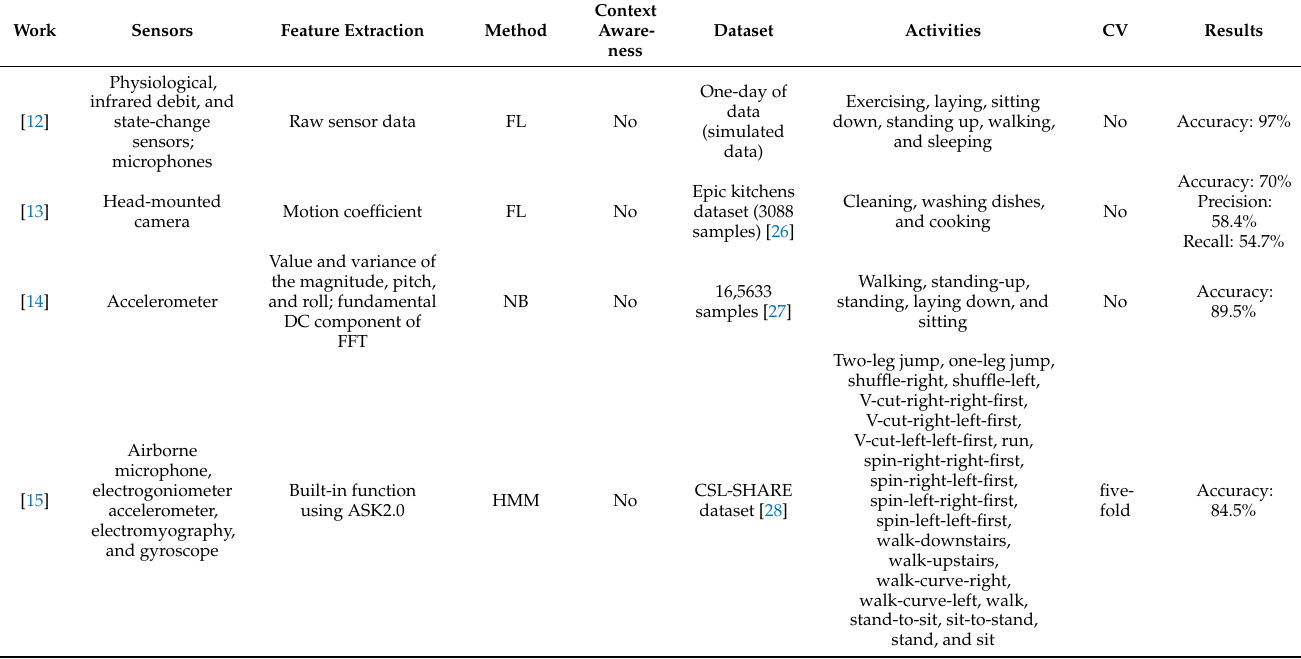
Table 1. Summary of the performance of existing works on